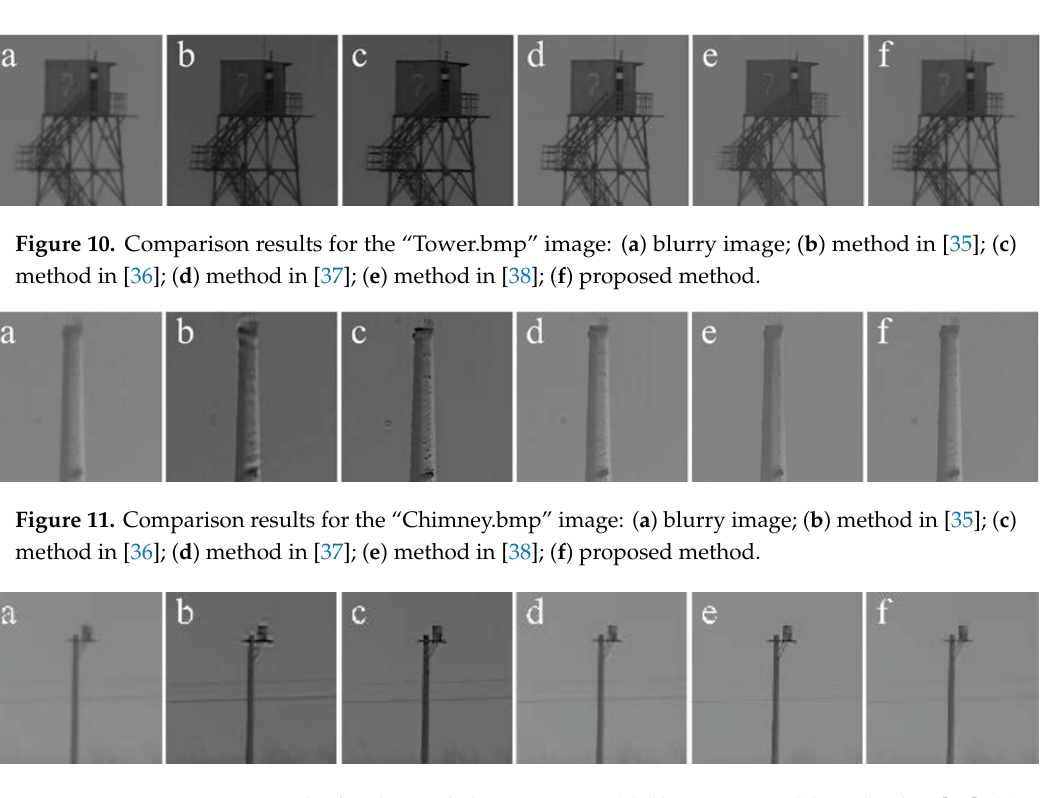
Figure 12. Comparison results for the “Pole.bmp” image: ( a ) blurry image; ( b ) method in [35]; ( c ) method in [36]; ( d ) method in [37]; ( e ) method in [38]; ( f ) proposed method.